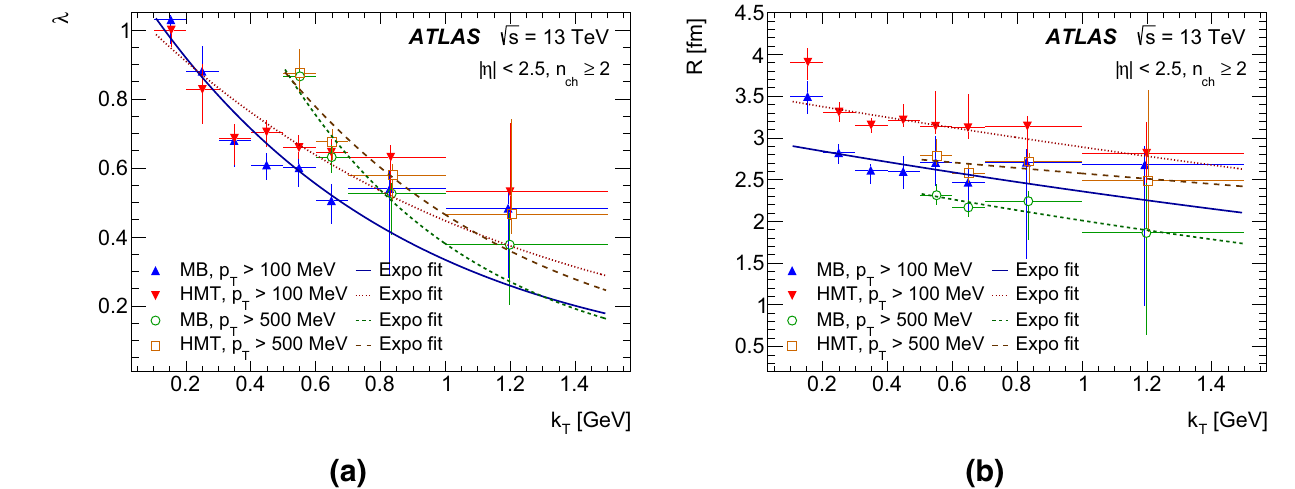
(MB) and high-multiplicity track (HMT) events for p T > 100 MeV √ s = 13 TeV. The total uncertainties are shown and p T > 500 MeV at